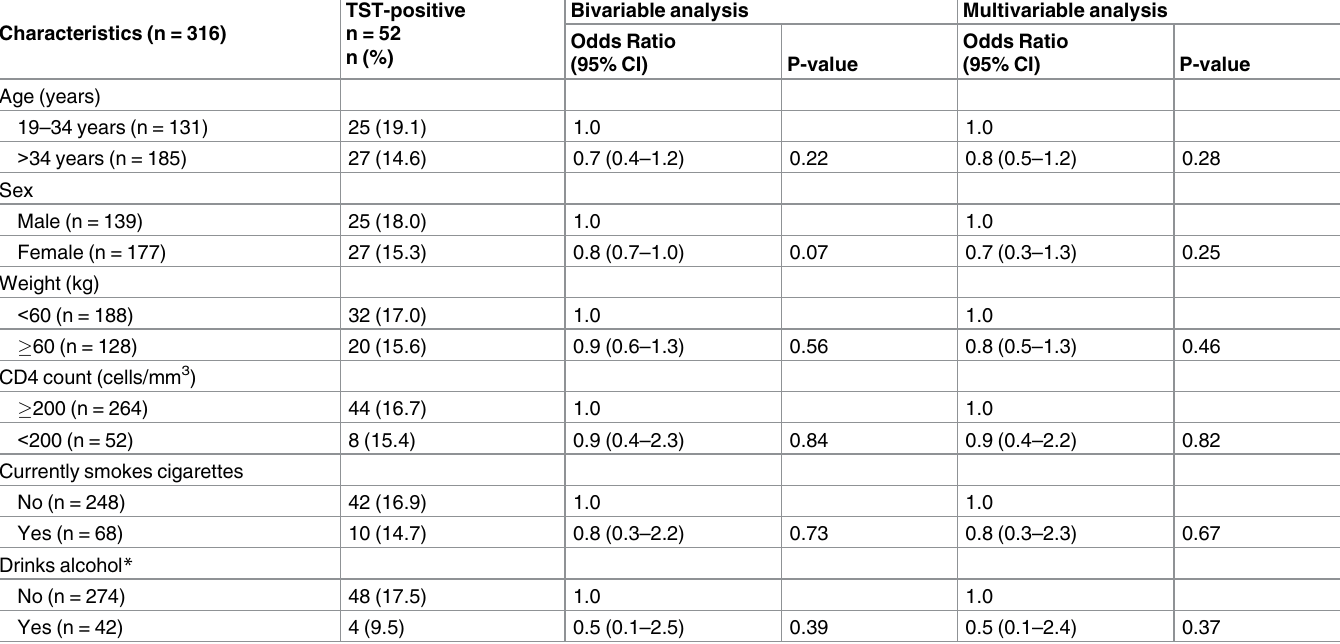
Table 4. Results of generalized estimating equations logistic regression analysis of baseline characteristics of 316 people living with HIV who had a tuberculin skin test (TST) to determine predictors of a positive TST result ( (cid:21) 5mm of